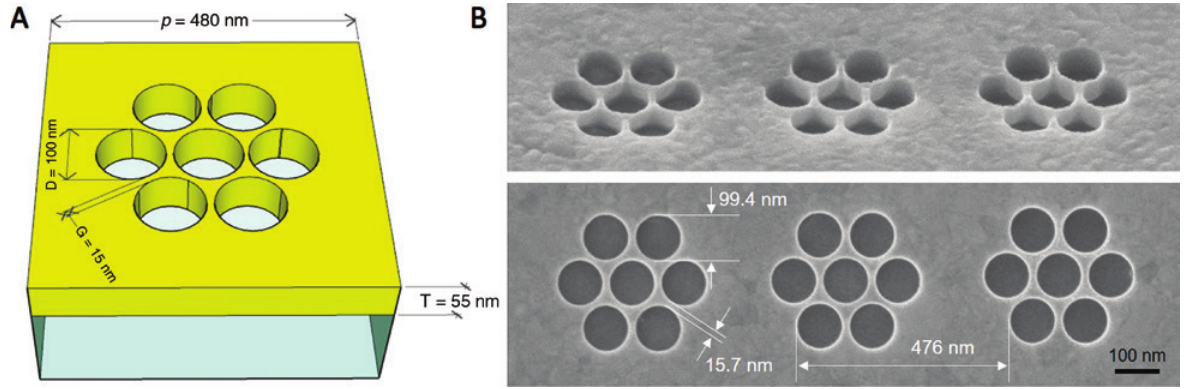
Figure 1: HNH array in an Au film. (A) Schematic of the HNH design with the target dimensions. The Au film (yellow) is 55 nm thick and is supported by an SiO substrate (light blue). (B) HIM images of HNHs fabricated via direct HeFIB milling. Top, 54 ° tilted view; bottom, top